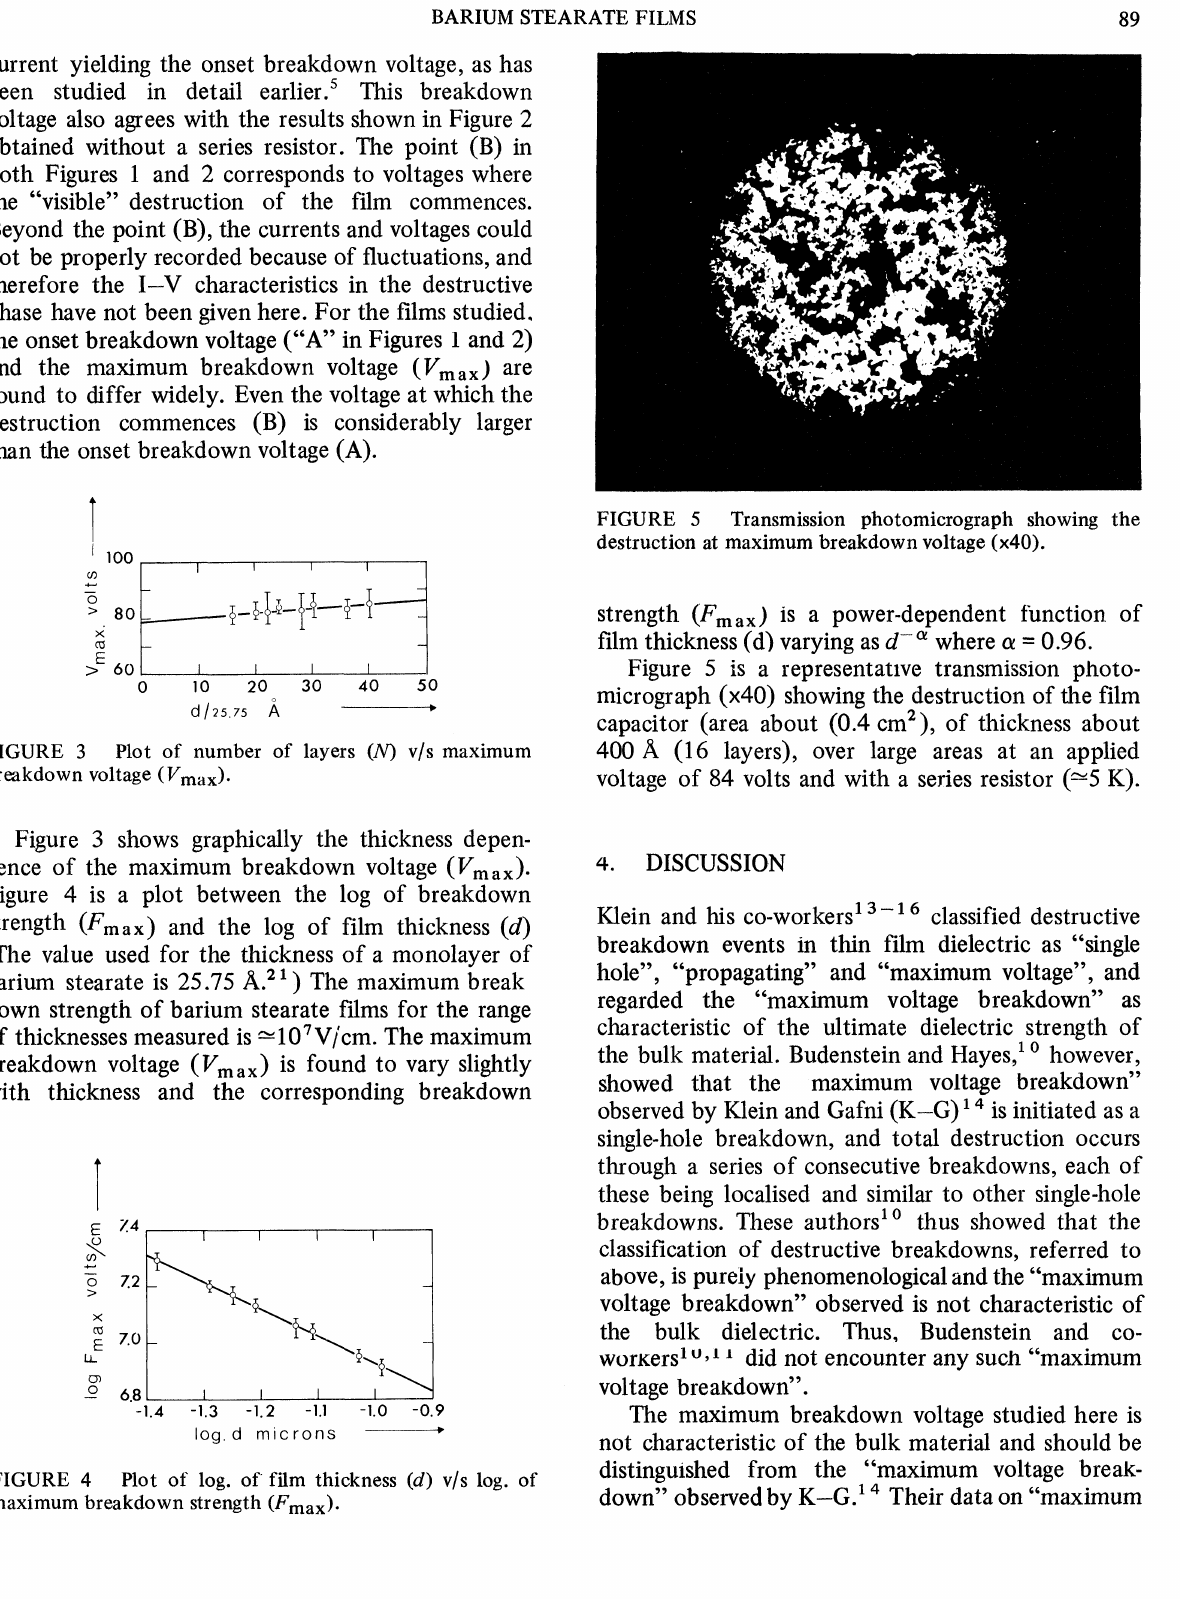
Plot of log. of film thickness (d) v/s log. of maximum breakdown strength